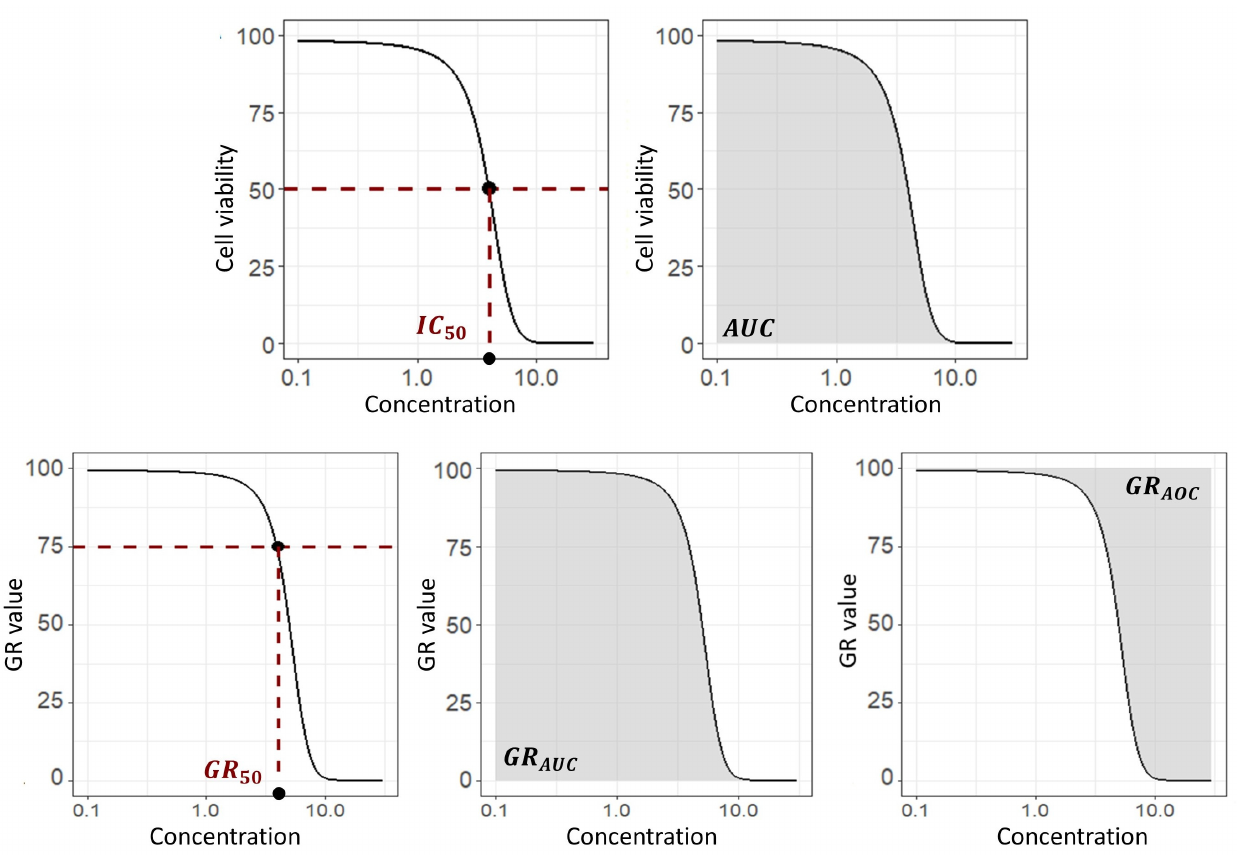
Figure 3. Efficacy metrics derived from cell viability-based assays. In the upper panels the IC50 and AUC metrics from the concentration–viability curve; in the lower panels the GR50, GRAUC and GRAOC metrics from the concentration-growth inhibition growth curve.